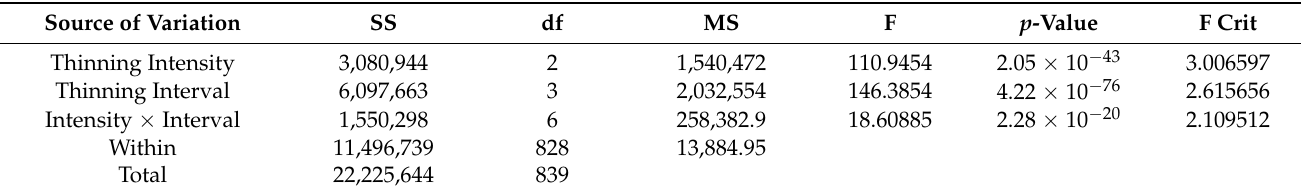
Table A5. Two-way ANOVA test for